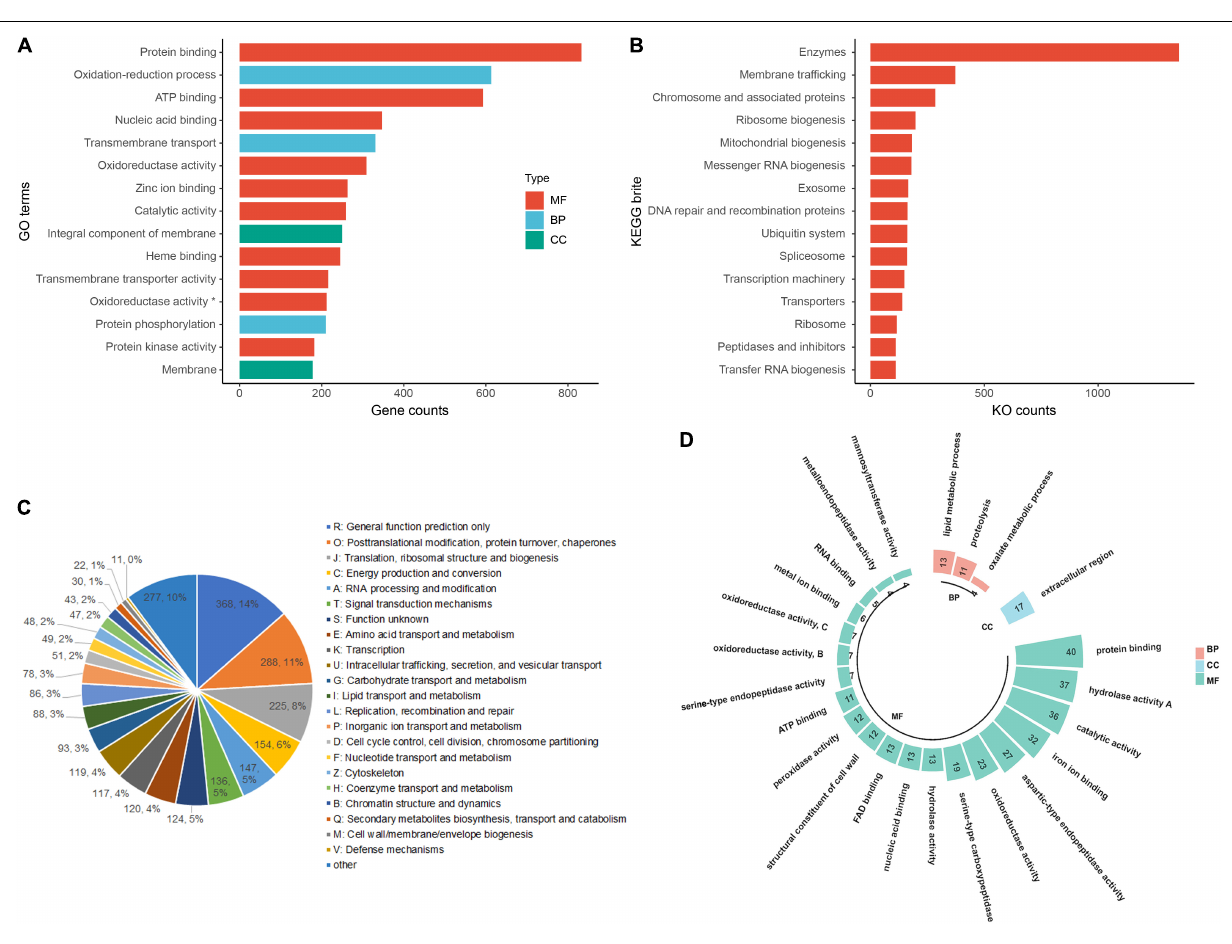
Frontiers in Microbiology |